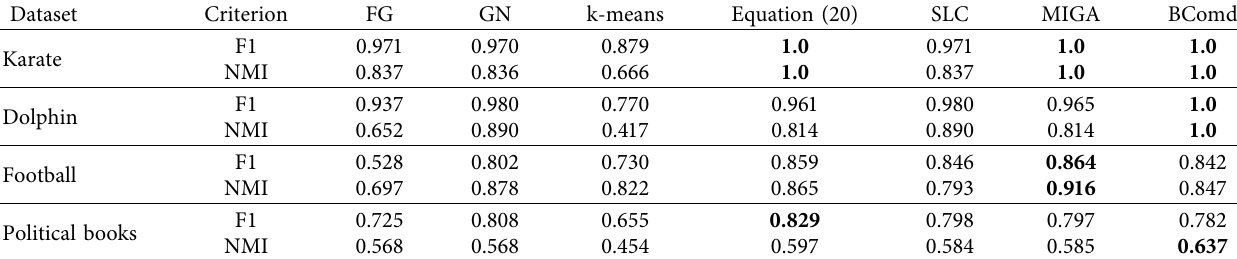
Table 2: Experimental results of the community-discovery algorithms on small graphs (F1 and NMI). Dataset